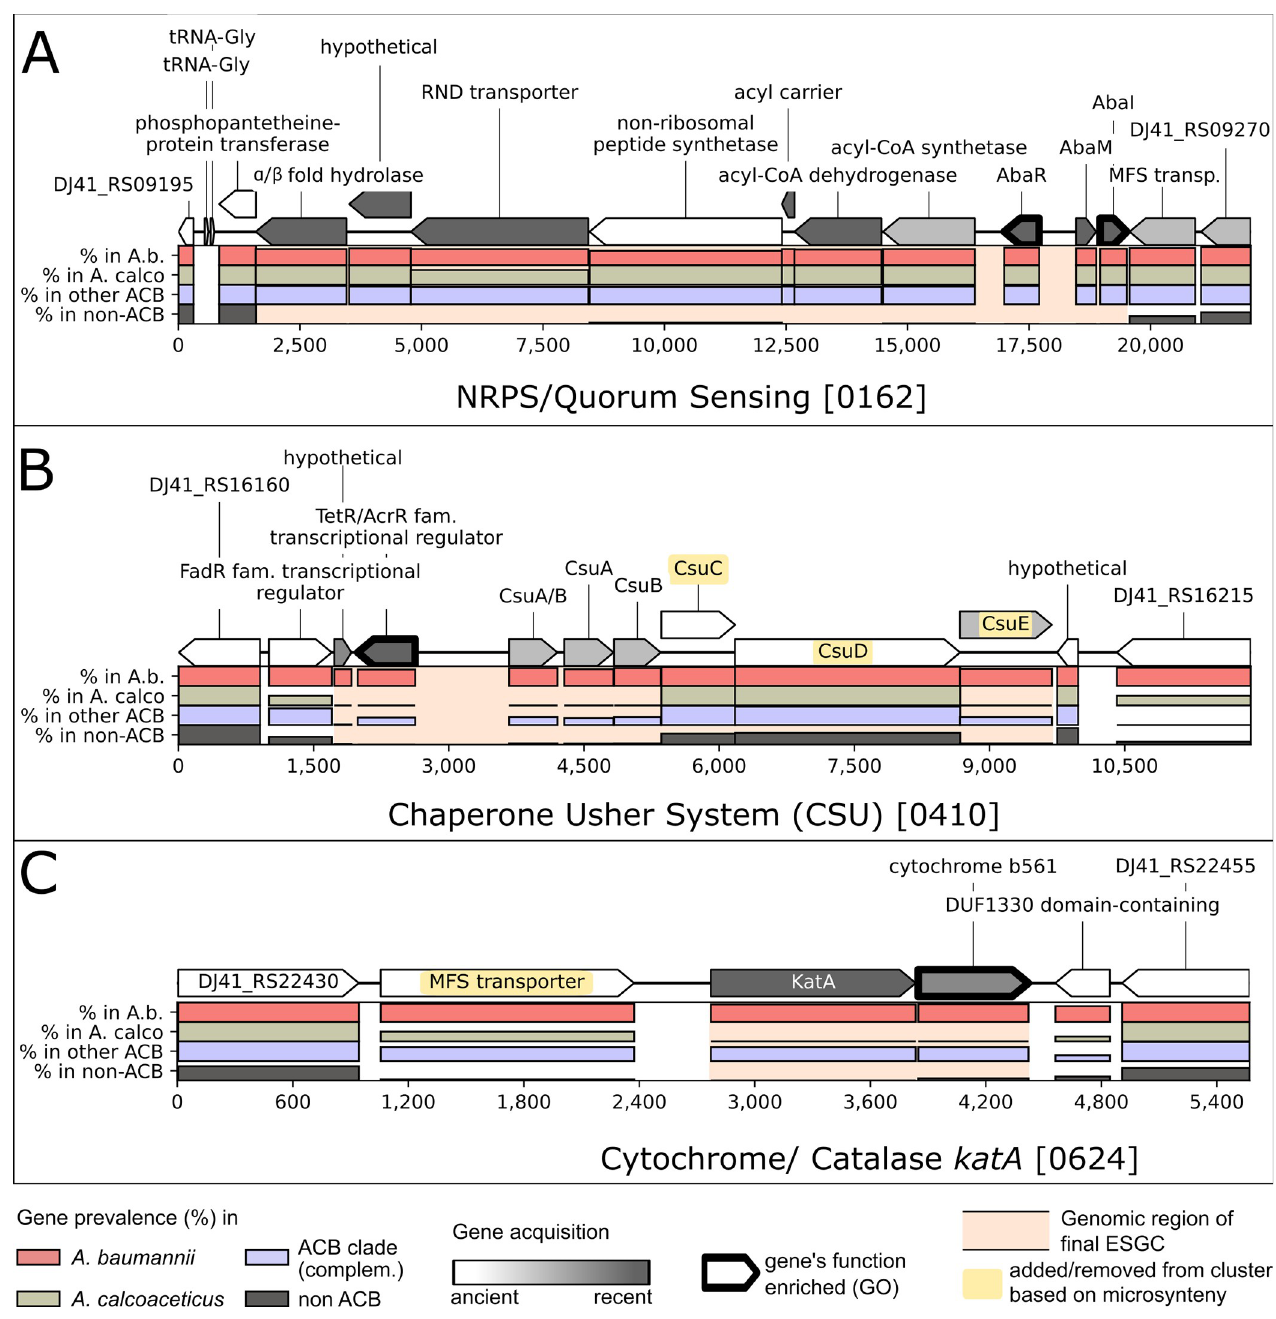
Fig 7. Three examples for ESGC ACB in the genome of Ab ATCC 19606. Bar plots indicate relative abundance within the selected taxonomic groups (see legend). The ESGC ACB are embedded into two flanking protein-coding genes on each side that are not part of the cluster. Cluster boundaries are indicated by a pink background. Genes indicated in yellow have been either added to or excluded from the automatically generated clusters based on microsynteny analyses across Set-R. (A) ESGC ACB − 0162 unites AbaR and AbaI (quorum sensing) with a non-ribosomal peptide synthetase cluster upstream. (B) ESGC ACB − 0410 encompasses the cluster necessary for the Csu pilus formation. Note the deviating abundance pattern for CsuC and CsuD, which is due to the presence of prpC and prpD, two paralogous genes from the photoregulated pilus ABCD (prpABCD), in the respective orthologous groups. Microsynteny analyses confirmed that the entire Csu cluster forms one evolutionary unit (S1 Data id:0410). (C) ESGC ACB − 0624 harbors a catalase and a cytochrome b561. Although the MFS transporter shares a similar abundance pattern across the taxa of Set-R, this transporter is not evolutionarily stably linked to the other two genes (S1 Data id:0624).